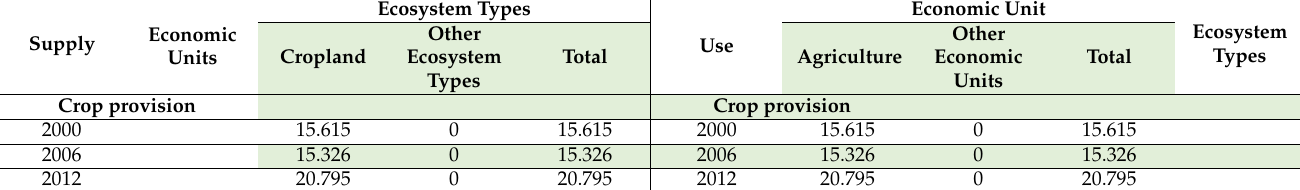
Table 1. Supply and use tables of one ecosystem service (million EUR, year